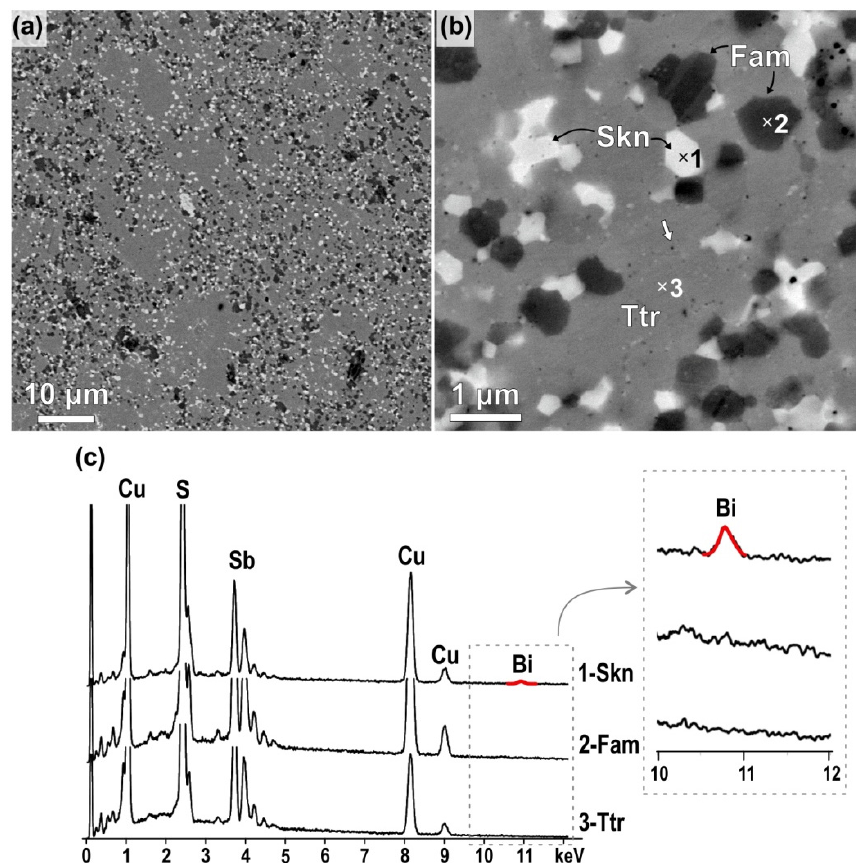
Figure 5. Backscattered SEM images of the sample with a nominal Bi content, X Bi = 0.2 at ( a ) lower and ( b ) higher magnification revealing the presence of three main phases with different average atomic densities (Z). ( c ) EDS spectra recorded from areas with different contrasts reveal detectable amounts of Bi only in